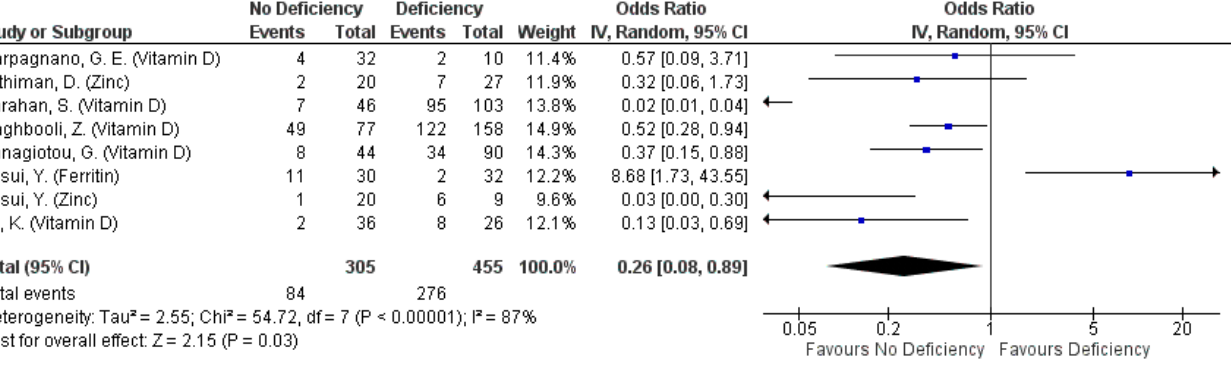
Figure 6. Pooled odds ratio on clinical severity of COVID-19 patients (defined by clinical condition, or need for breathing support) hospitalized subjects are not deficient, compared to those deficient in any micronutrient singly.